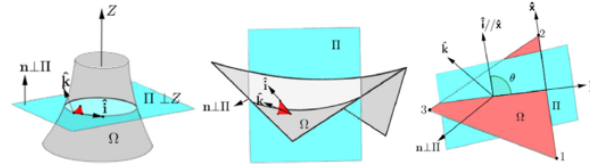
Figure 4: Definition of an orthotropic initial stress field by using director places [15].